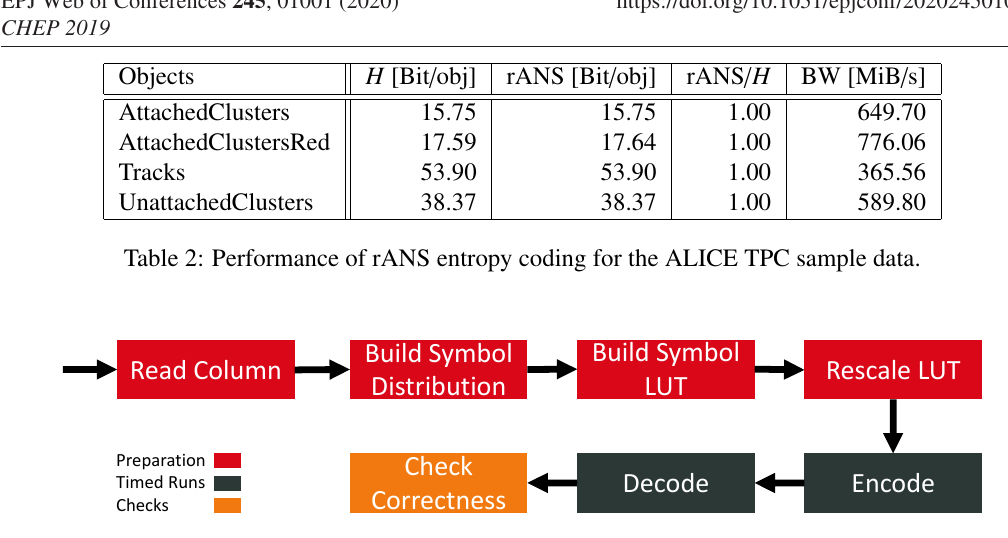
Figure 3: Testbed for benchmarking rANS on the ALICE TPC sample